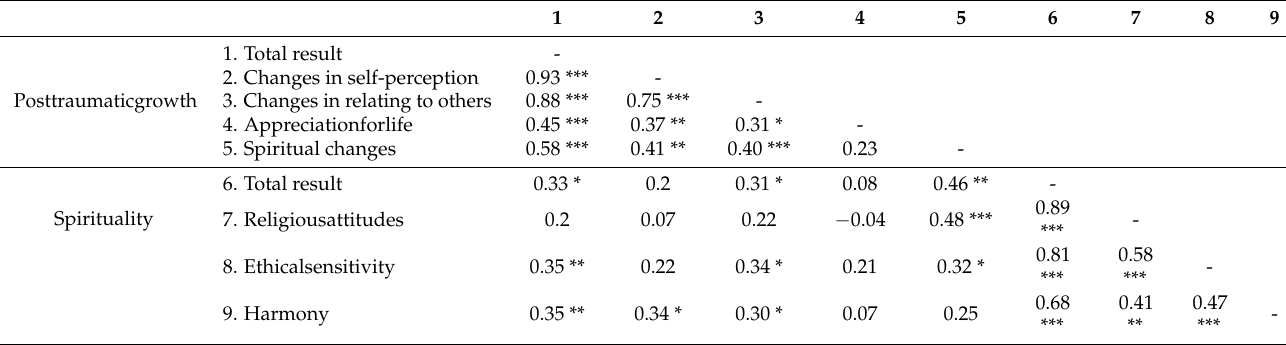
Table 2. Results of the analysis of the rho-Spearman correlation between posttraumatic development and spirituality in mothers in the event of a child’s cancer ( n = 55).